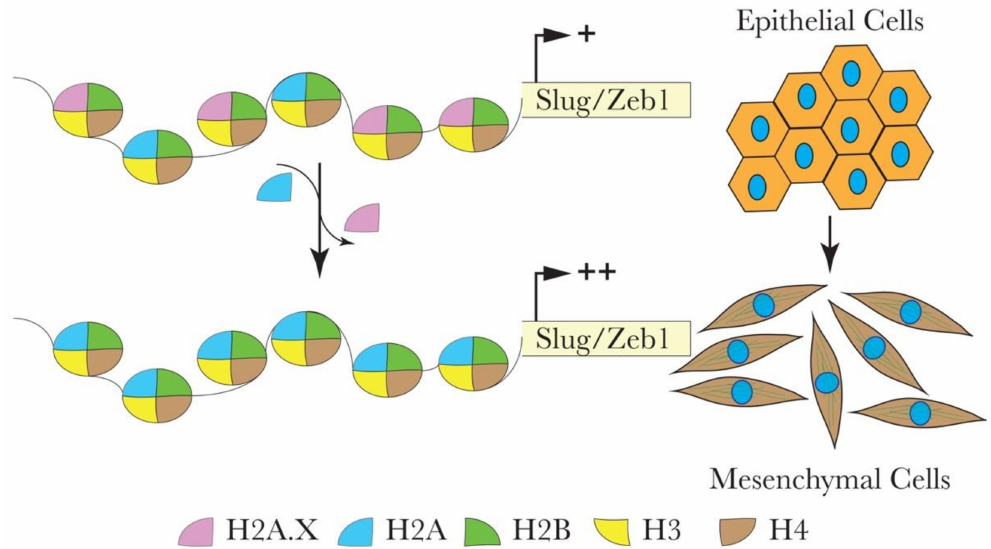
Figure 2. Hypothetical model for the role of H2A.X in the transcriptional regulation of Slug and ZEB1 during EMT in colon cancer HCT116 cells. H2A.X removal from the nucleosome leads to the enhanced enrichment of active chromatin marks within the promoters of Slug and ZEB1. This chromatin configuration enables the transcriptional activation of Slug and ZEB1. Elevated levels of Slug and ZEB1 are vital in mediating the expression of several EMT-related